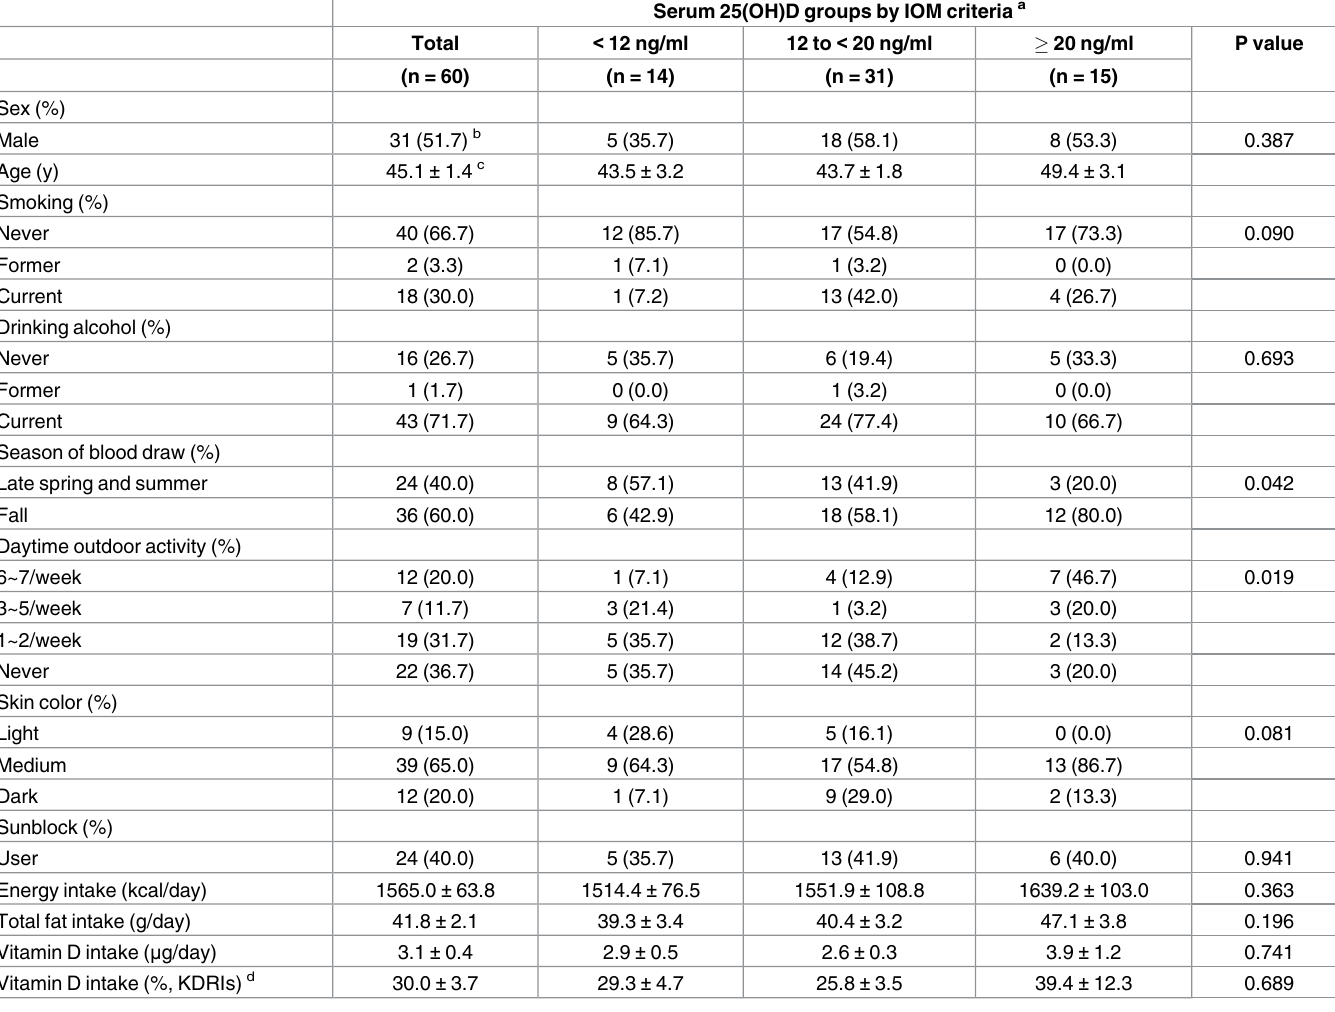
Table 1. General characteristics of Korean prediabetic adults by serum 25(OH)D